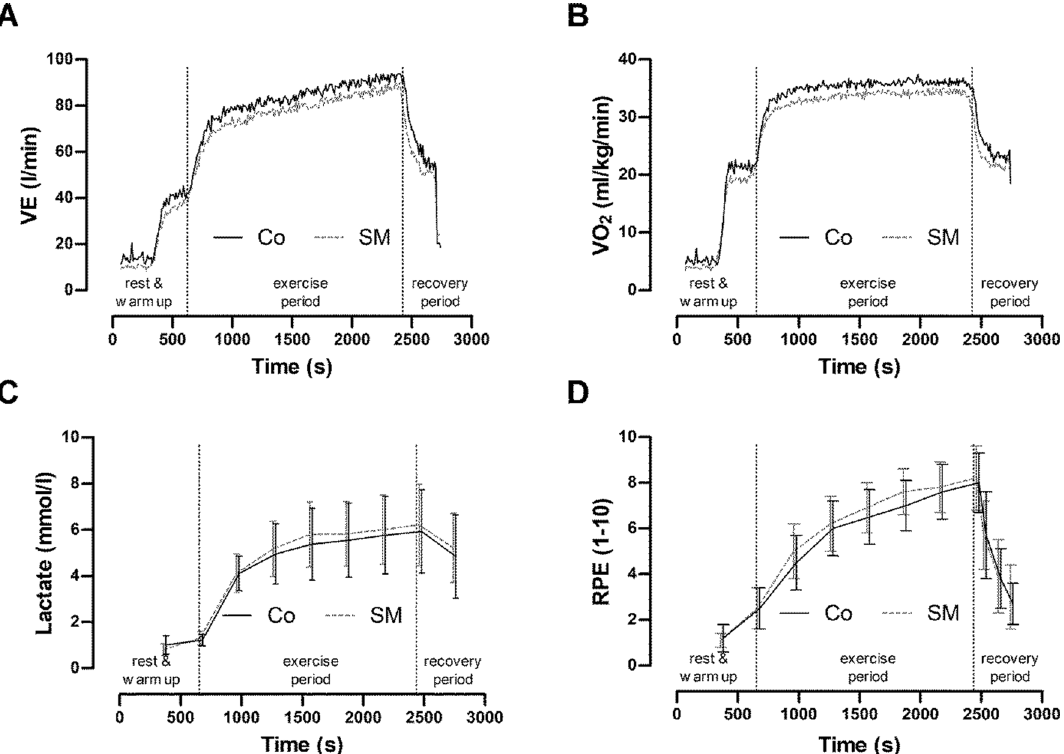
Figure 4. The graphs show the mean cardiac responses (n = 13) during the continuous load test with and without a surgical mask. ( A ) VE: minute ventilation; ( B ) VO 2 : oxygen uptake; ( C ) LAC: blood lactate concentration; ( D ) RPE: rating of perceived exertion ( D ). The rest values were determined immediately prior to